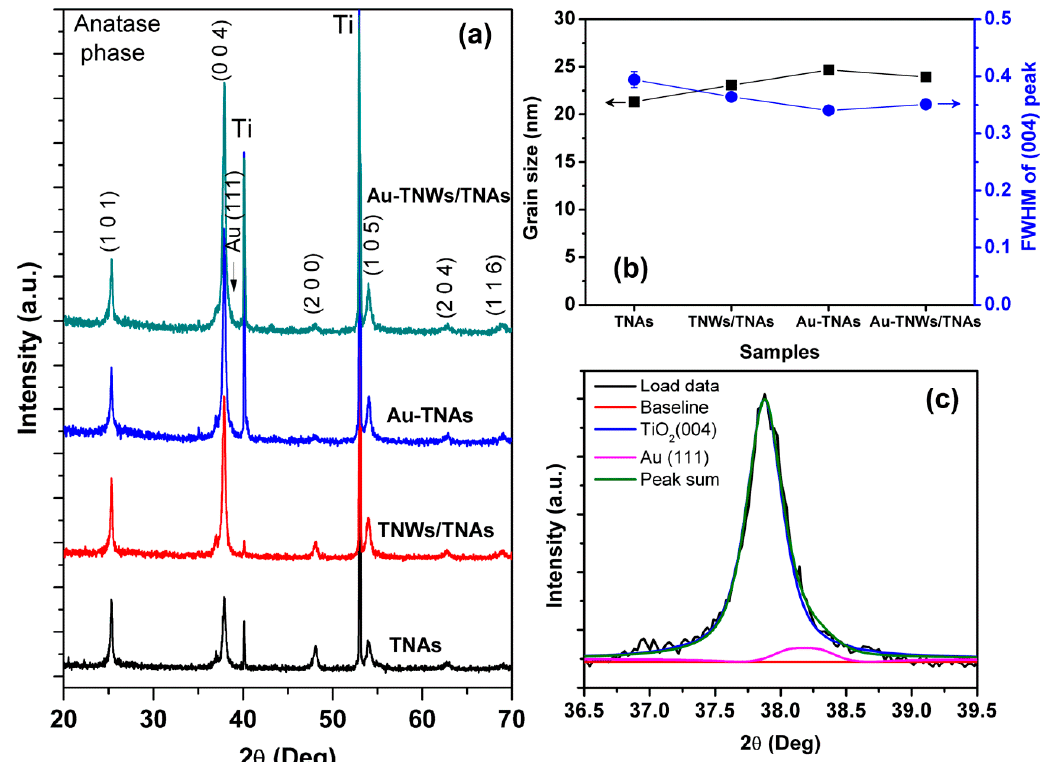
Figure 1. ( a ) The XRD patterns of TiO 2 nanotube arrays (TNAs), TiO 2 nanowires on nanotube arrays (TNWs / TNAs), Au-TNAs, and Au-TNWs / TNAs. ( b ) Grain size and the full width at half maximum (FWHM) of (004) peaks of the four nanomaterials. ( c ) The (004) peak of Au-TNAs shows two components of TiO 2 (004) and Au (111).